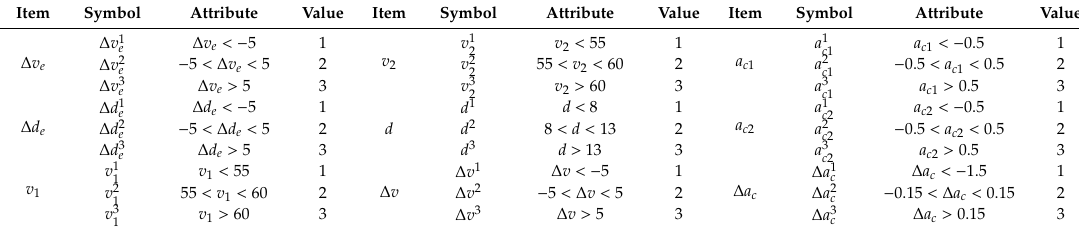
Table 2. Rules for data